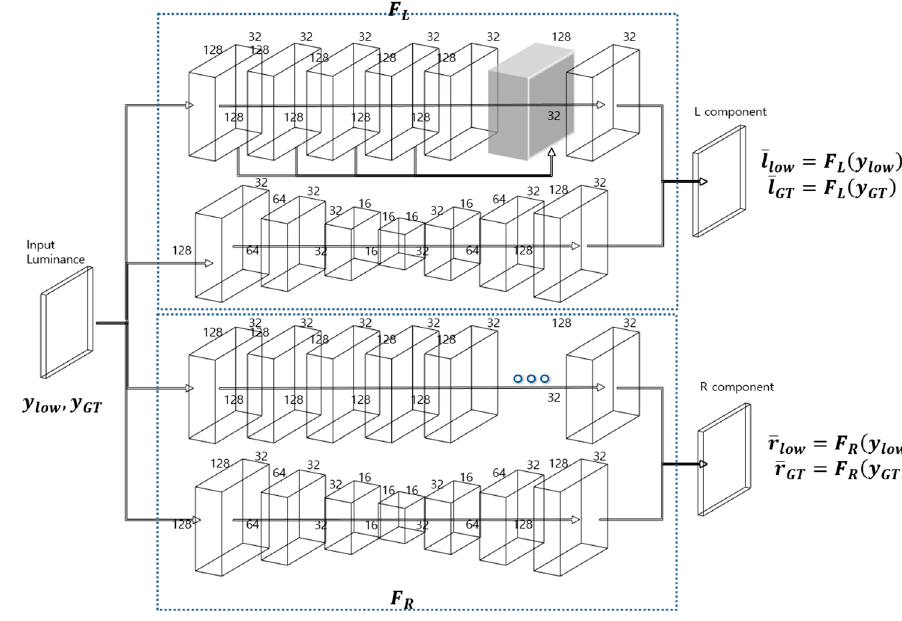
Figure 1. Conceptual diagram of proposed decomposition network.